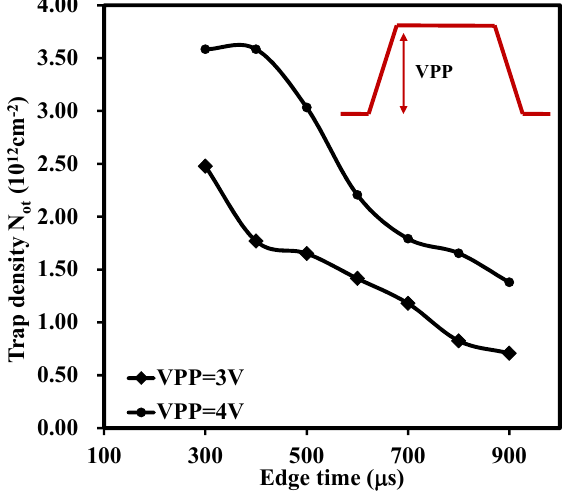
Figure 5. Variation of N ot versus edge time with V PP for the sample with thickness of 22